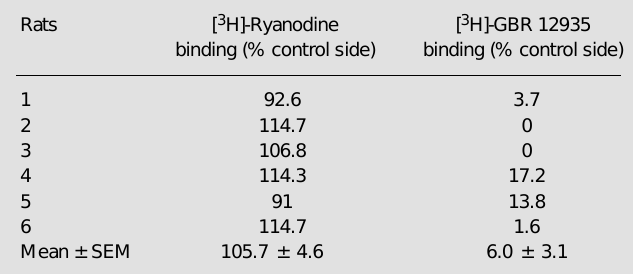
Table 1 - Specific binding of [ 3 H]-ryanodine and [ 3 H]-GBR 12935 to crude membrane preparations from striatum of 6-OHDA-lesioned rats. Specific binding of [ 3 H]-ryanodine and [ 3 H]-GBR 12935 in right striatum (corresponding to the side of the substantia nigra lesioned by 6-OHDA injection) is reported as percent of specific binding measured in the contralateral striatum (control side). Specific binding accounts for 62 and 51% of total binding for [ 3 H]-ryanodine and [ 3 H]-GBR 12935,